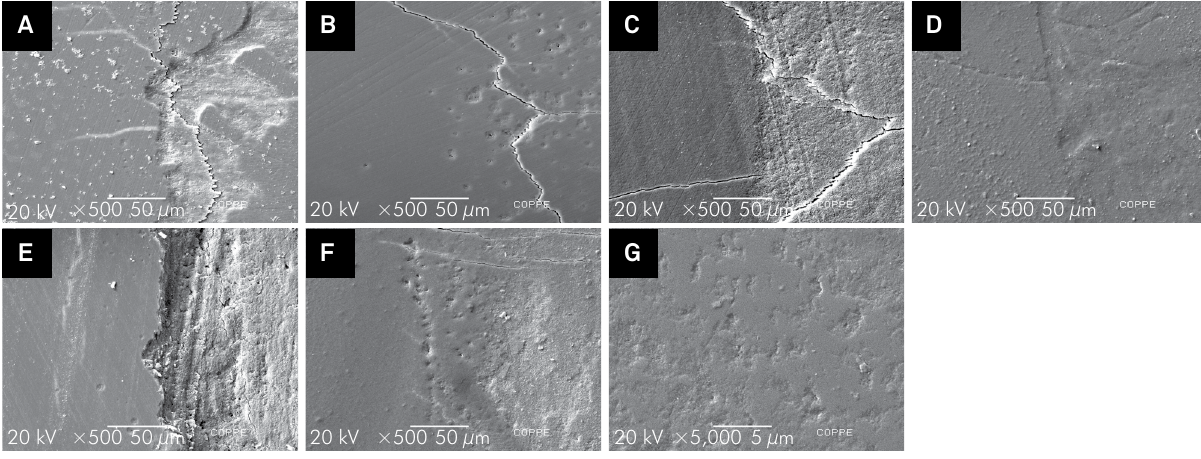
Figure 2. SEM images of enamel surfaces after treatment and pH cycling at 500X. Photomicrographs of the interface: left – sound window (unexposed area) and right – experimental window (exposed area). (A) G1: Alivium ® , (B) G2: Novalgina ® , (C) G3: Betamox ® , (D) G4: Clavulin ® , (E) G5: Claritin ® , (F) G6: Polaramine ® , and (G) G7: Milli-Q water (negative